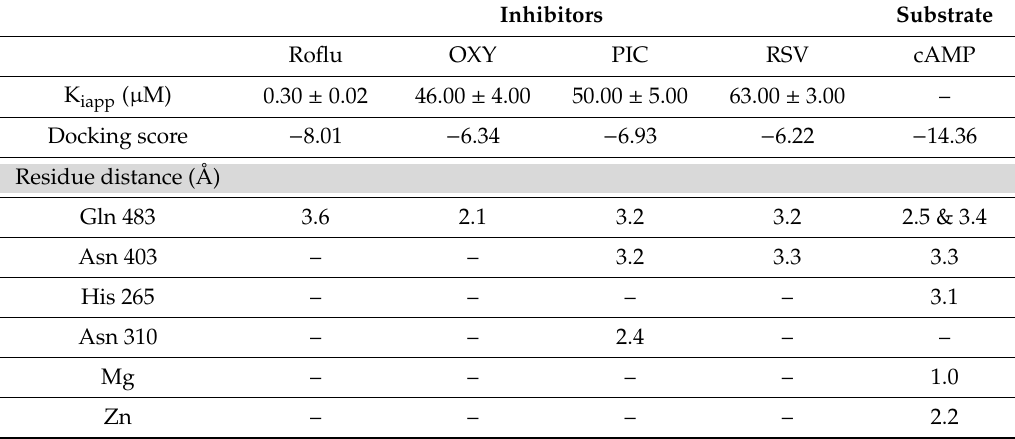
Table 1. Experimental K i of values predicted docking score for each molecule and hydrogen bond residue distance. Inhibitors Substrate Roflu